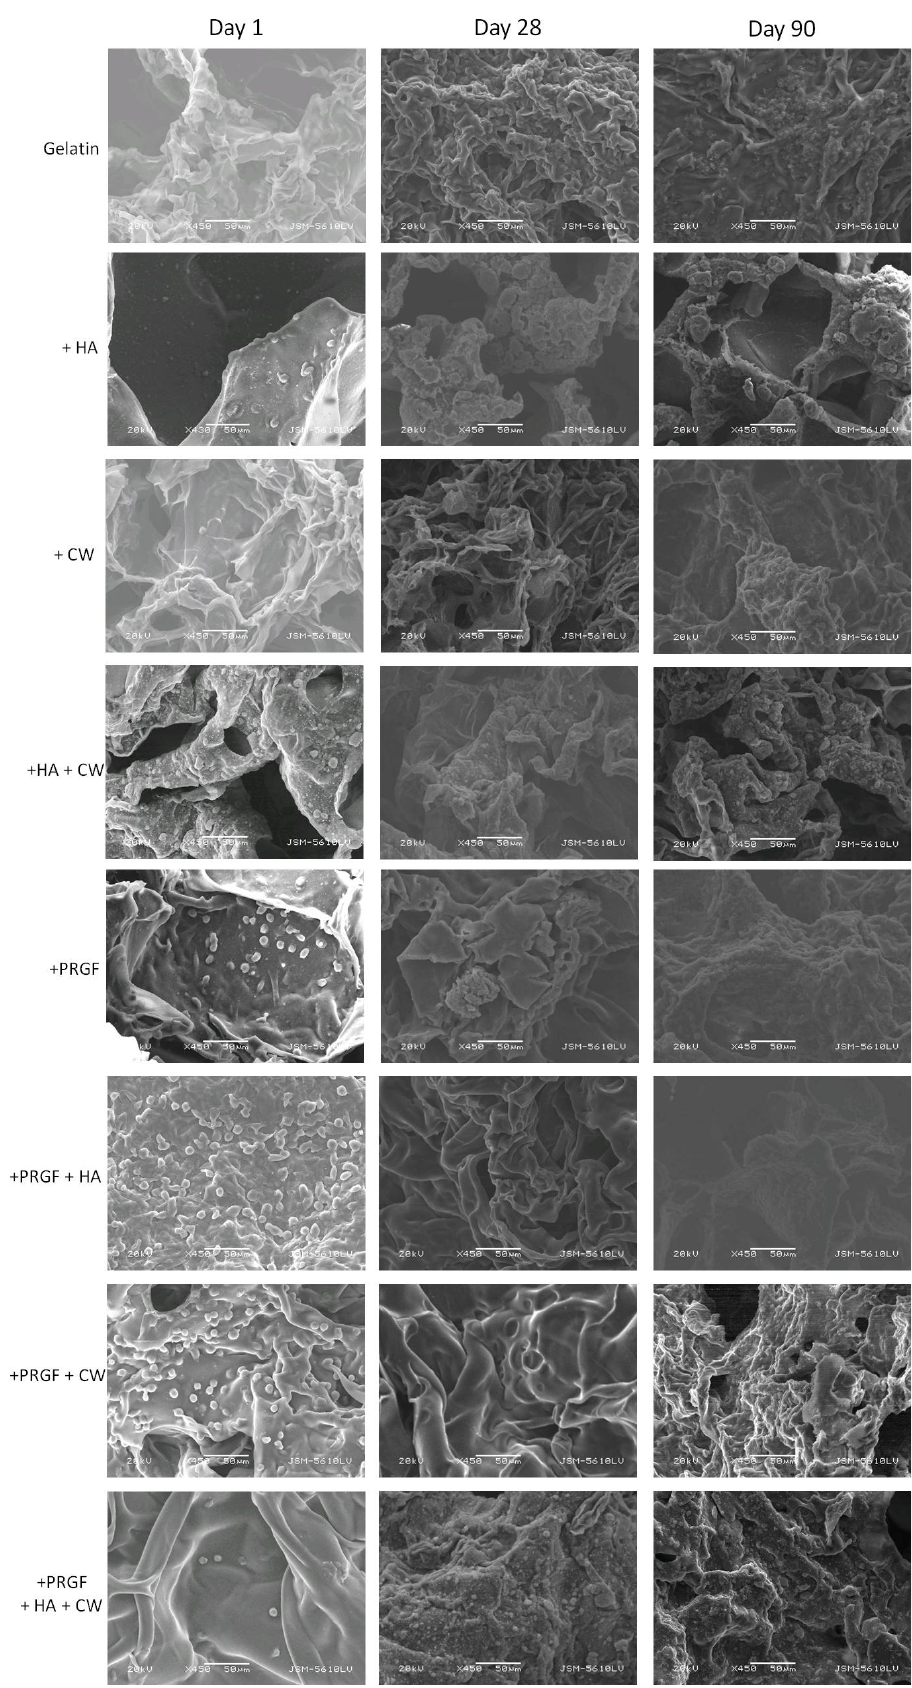
Figure 5. SEM of +EDC cross-linked scaffolds seeded with MG-63 cells for 1, 28, and 90 days. Magnification at 450× and scale bars at 50